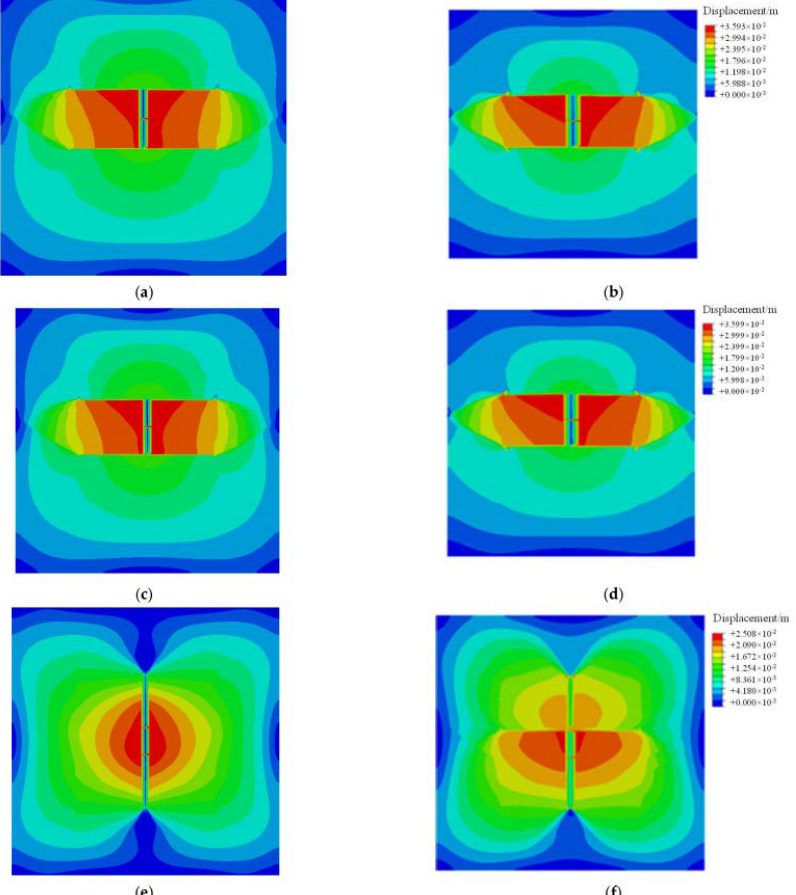
Figure 5. Cloud picture of displacement under different bedding shear strengths: ( a ) shear strength of 12 MPa and time t = 55 s; ( b ) shear strength of 12 Mpa and time t = 100 s; ( c ) shear strength of 16 Mpa and time t = 55 s; ( d ) shear strength of 16 Mpa and time t = 100 s; ( e ) shear strength of 20 Mpa and time t = 55 s (base case); and ( f ) shear strength of 20 Mpa and time t = 100 s (base